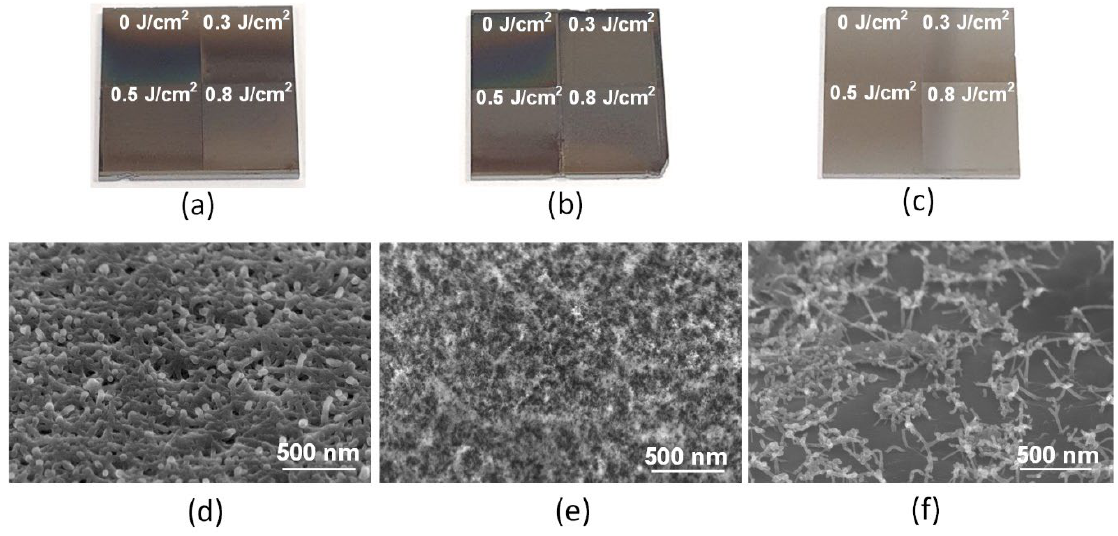
Figure 7. External view of ( a ) SWCNT, ( b ) rGO, and ( c ) rGO + SWCNT layers after laser exposure with energy densities of 0, 0.3, 0.5, and 0.8 J/cm 2 in an Ar gas environment; ( d – f ) Corresponding SEM images obtained when exposed to an energy density of 0.5 J/cm 2 .